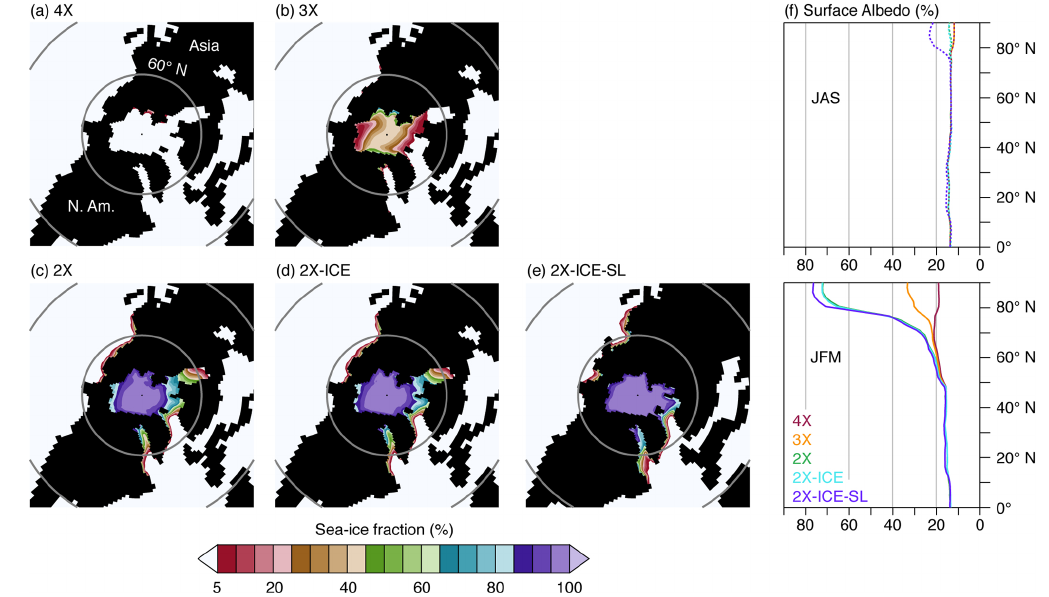
Figure 3. Northern Hemisphere winter sea-ice fraction and surface albedo